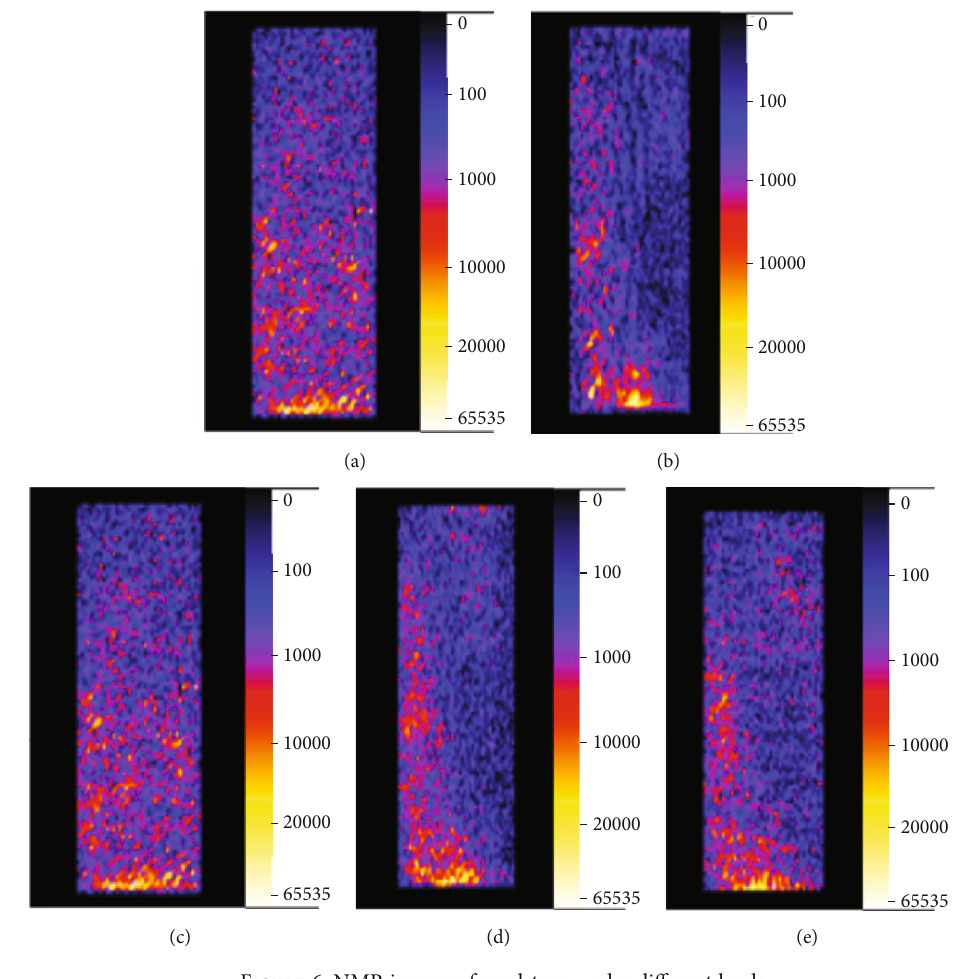
Figure 6: NMR images of sandstone under di ff erent loads. Table 2: Sandstone pore throat distribution under di ff erent